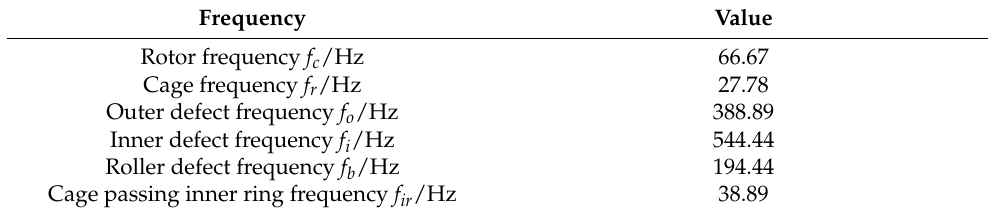
Table 3. Defect frequencies for the simulated